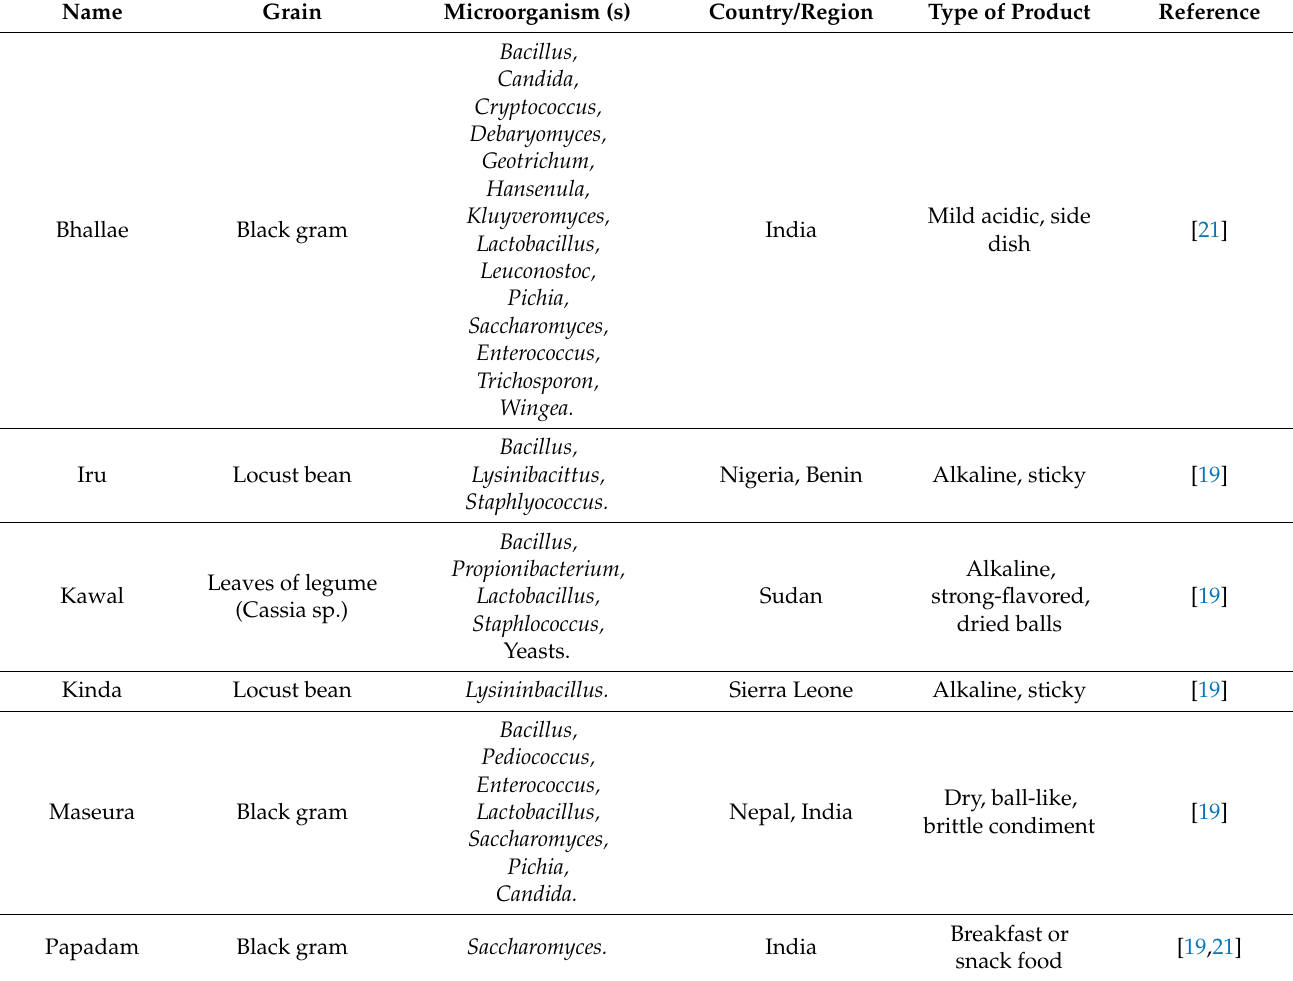
Table 4. Examples of alkali-fermented MG foods used in different regions of the